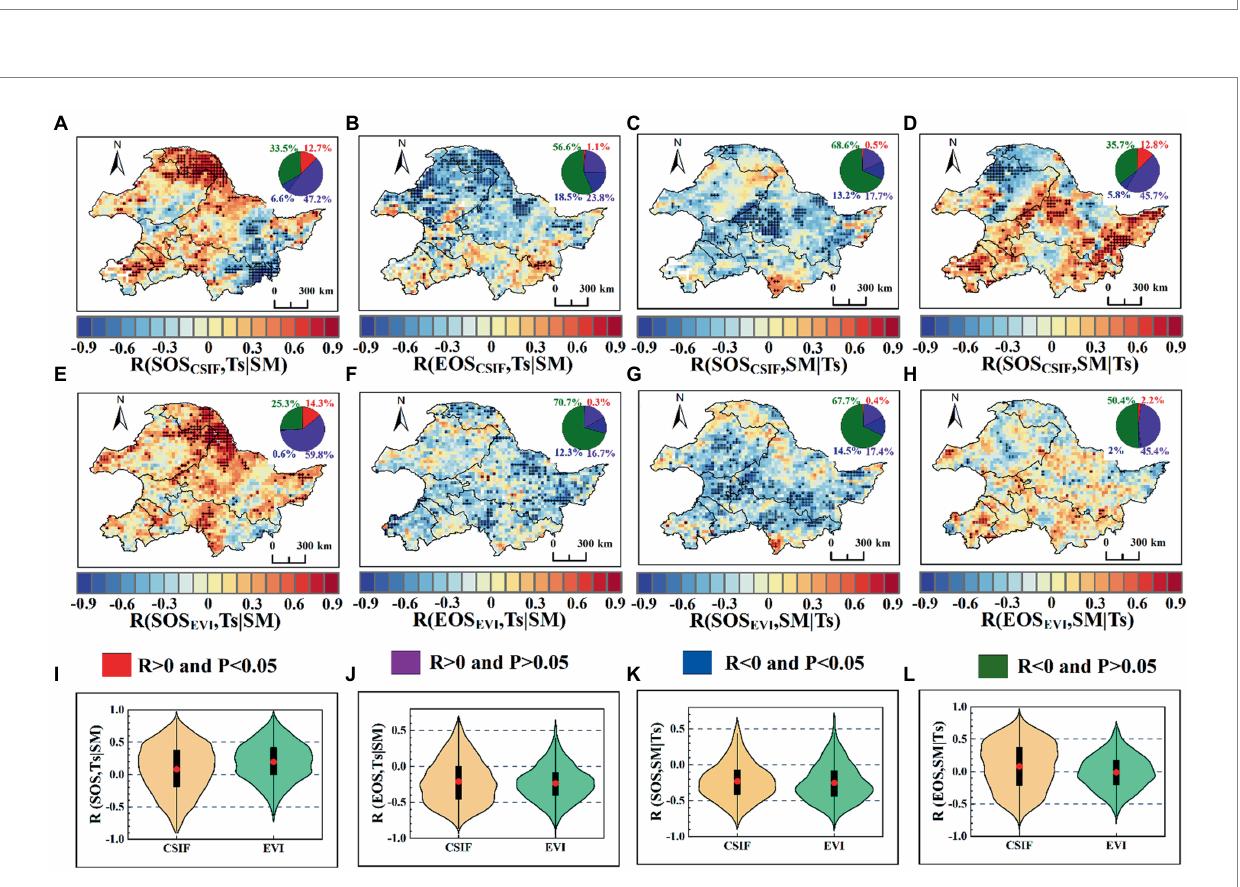
FIGURE 7 Spatial patterns of partial correlations between SOS and EOS extracted from CSIF and EVI and preseason Ts, SM. (A–D) Spatial patterns of partial correlation coefficients between SOS, EOS derived CSIF and preseason Ts, SM; (E–H) Spatial patterns of partial correlation coefficients between SOS, EOS derived EVI and preseason Ts, SM; (I–L) Violin plots, where red dots indicate the mean, black rectangular boxes cover the interquartile range, and thin black lines reach the 5th and 95th percentiles. The black dot markers indicate that the 95% significance level was reached.